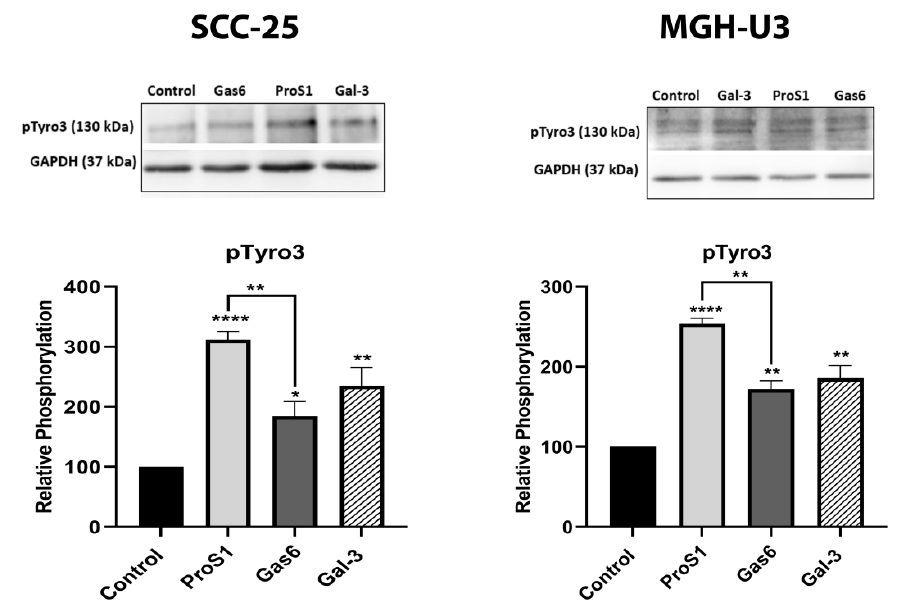
Figure 3. E ff ects of Gal-3 and the canonical TAM ligands, ProS1 and Gas6, on stimulation of phosphorylation of Tyro3 RTK in human cancer cells. Western blot showing Tyro3 phosphorylation (pTyro3) in serum-starved SCC-25 cells and MGH-U3 cells in response to addition of Gas6 (5.7 nM), ProS1 (7.5 nM) or Gal-3 (0.2 µ M) for 9 min. Data are the mean ± SEM protein expression normalised against loading control protein GAPDH ( n ≥ 3 experiments). ANOVA with Tukey’s multiple comparison post-hoc analysis. * p < 0.05, ** p < 0.01, **** p < 0.0001 and ns, not significant vs. the control or between treatments as indicated by lines.